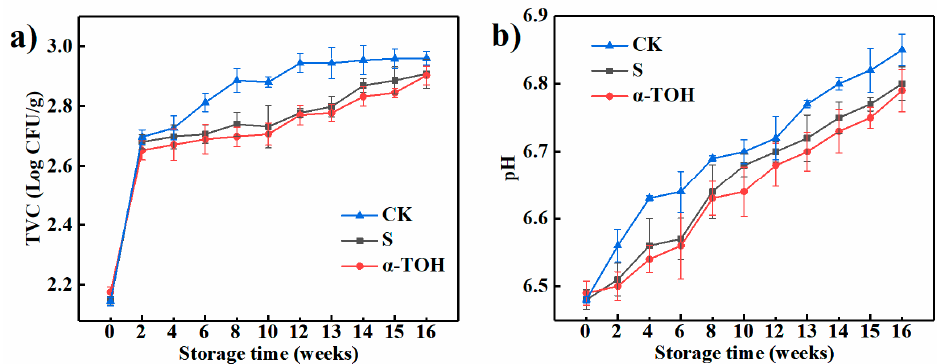
Figure 2. Effects of α -TOH on the total viable count ( a ) and pH value ( b ) of sturgeon surimi during 16-week frozen storage at − 18 °C. Bars represent the standard deviation from triplicate determinations ( n = 3; 3 means 3 replicates) of the sturgeon surimi gels in different temperature treatments.